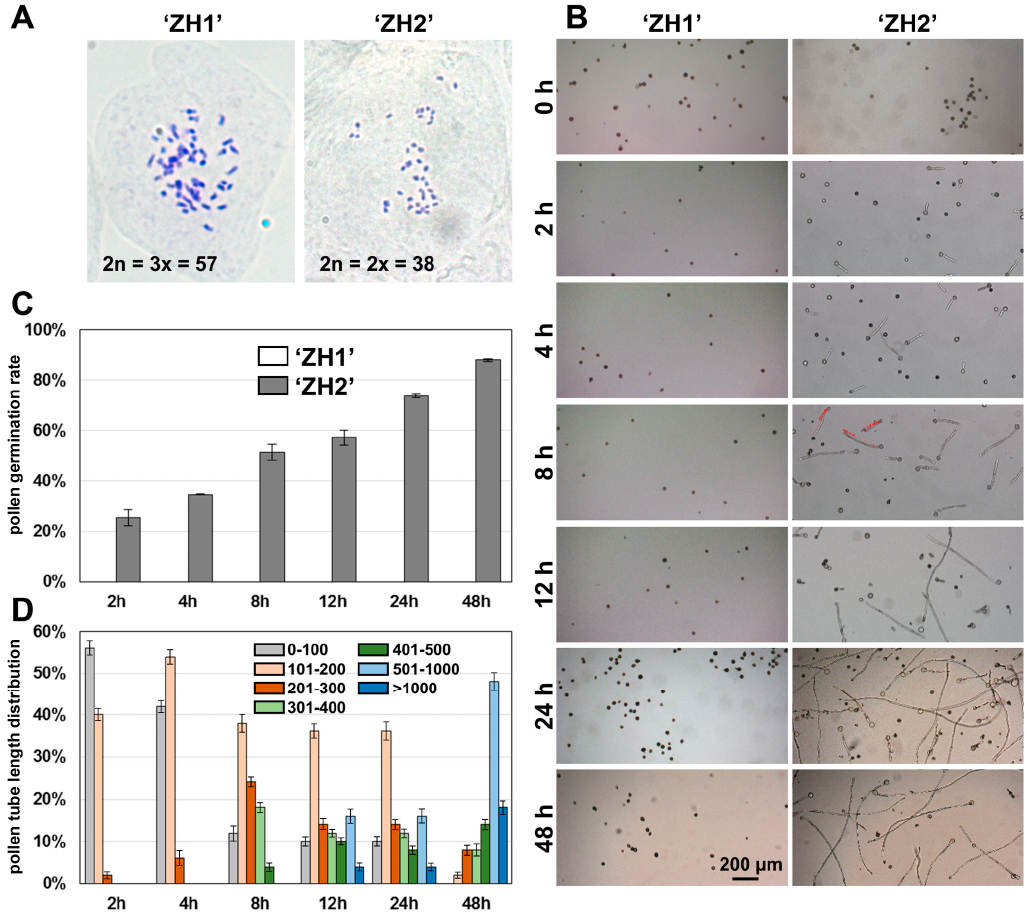
Figure 1. Pollen germination of triploid ‘ZH1’ and diploid ‘ZH2’ P. deltoides . ( A ) Somatic chromosome number in triploid poplar ‘ZH1’ and diploid poplar ‘ZH2’; ( B ) pollen tube growth of ‘ZH1’ and ‘ZH2’ during the germination (2, 4, 8, 12, and 24 h); ( C ) pollen germination rate of ‘ZH1’ and ‘ZH2’; ( D ) pollen tube length distribution of ‘ZH2’ pollen during the germination.